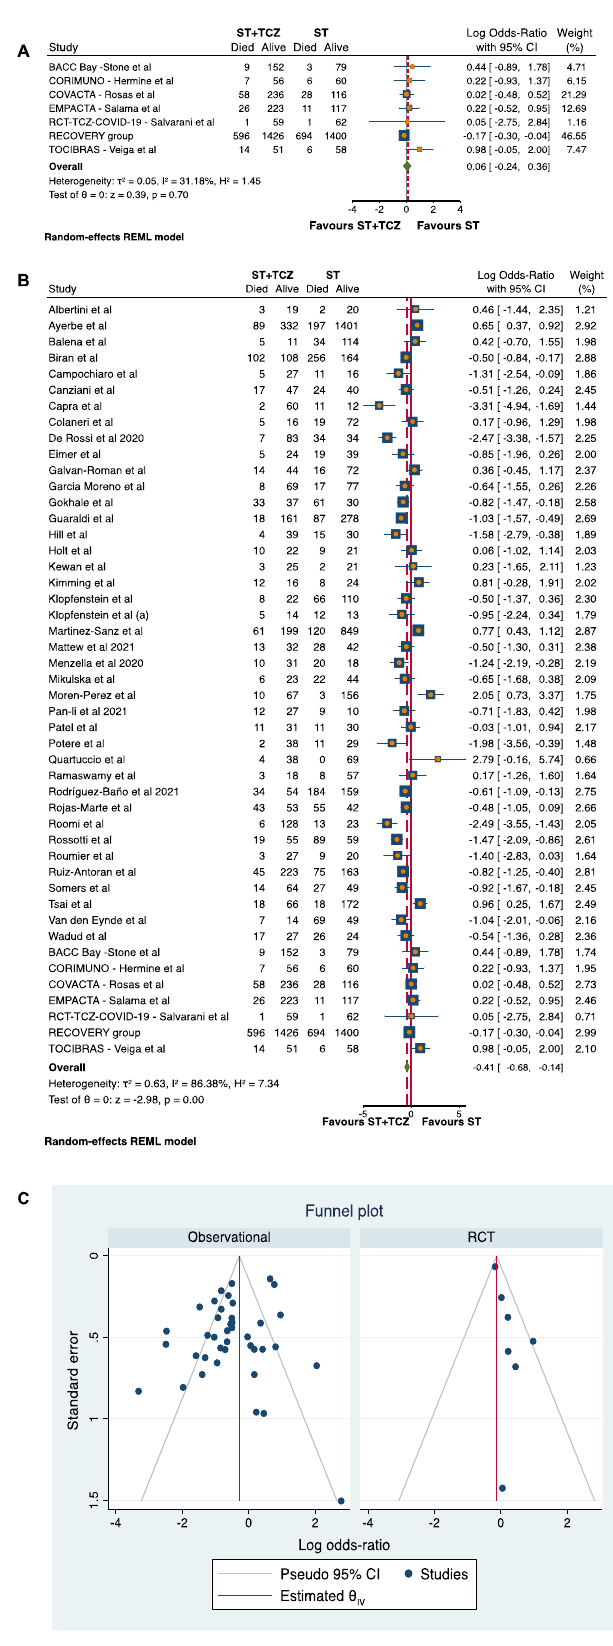
Figure 2. Forest plot in ( A ) RCTs and ( B ) observational studies. ( C ) Funnel plot of the subgroup analysis by RCTs and observational